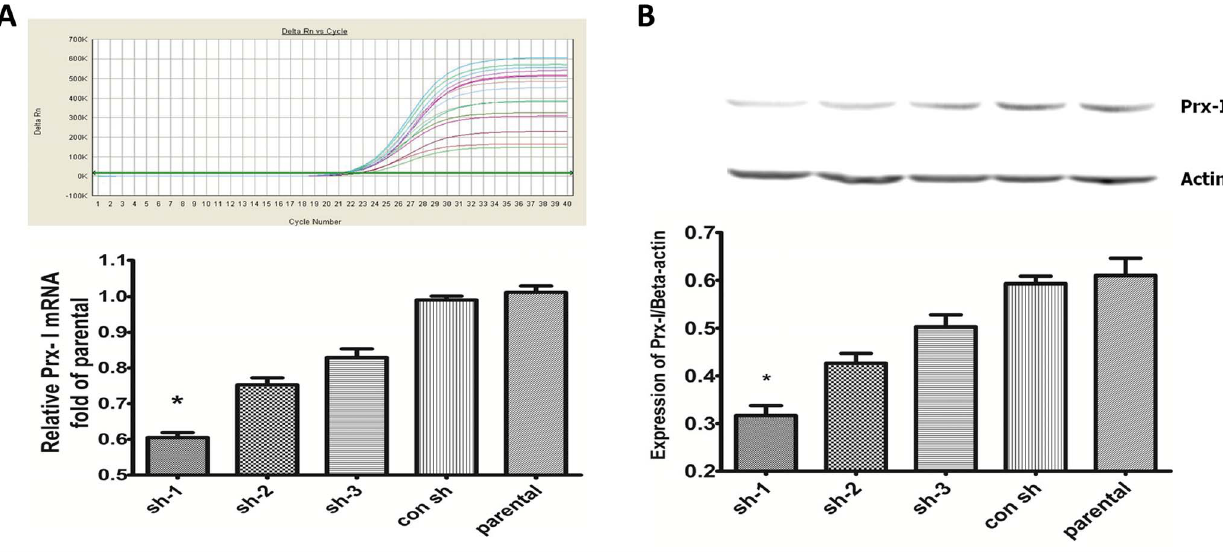
Figure 4. Suppression of Prx-I expression with the shRNA vectors in T24 cells. A: The expression of Prx-I mRNA was examined by qPCR. GAPDH served as an internal control. B: The Prx-I protein levels were analyzed by Western blot after transfection. Sh-1 treatment led to a significant reduction in Prx-I protein expression in T-24 cells. (Asterisk (*) indicates P , 0.05 in sh-1 group versus parental group)